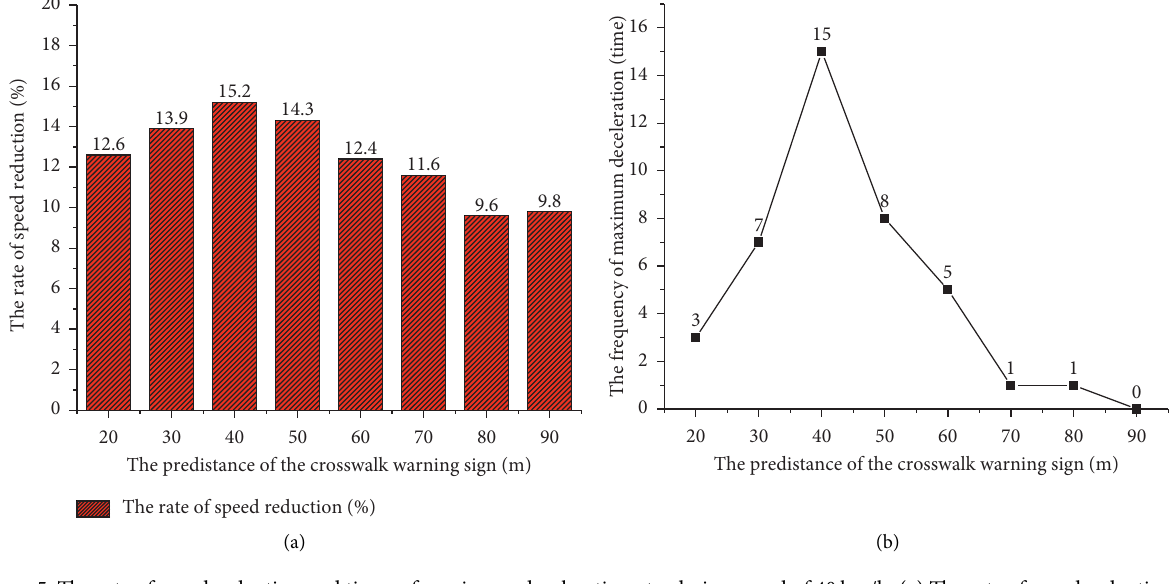
Figure 5: The rate of speed reduction and times of maximum deceleration at a design speed of 40km/h. (a) The rate of speed reduction. (b) The frequency of maximum